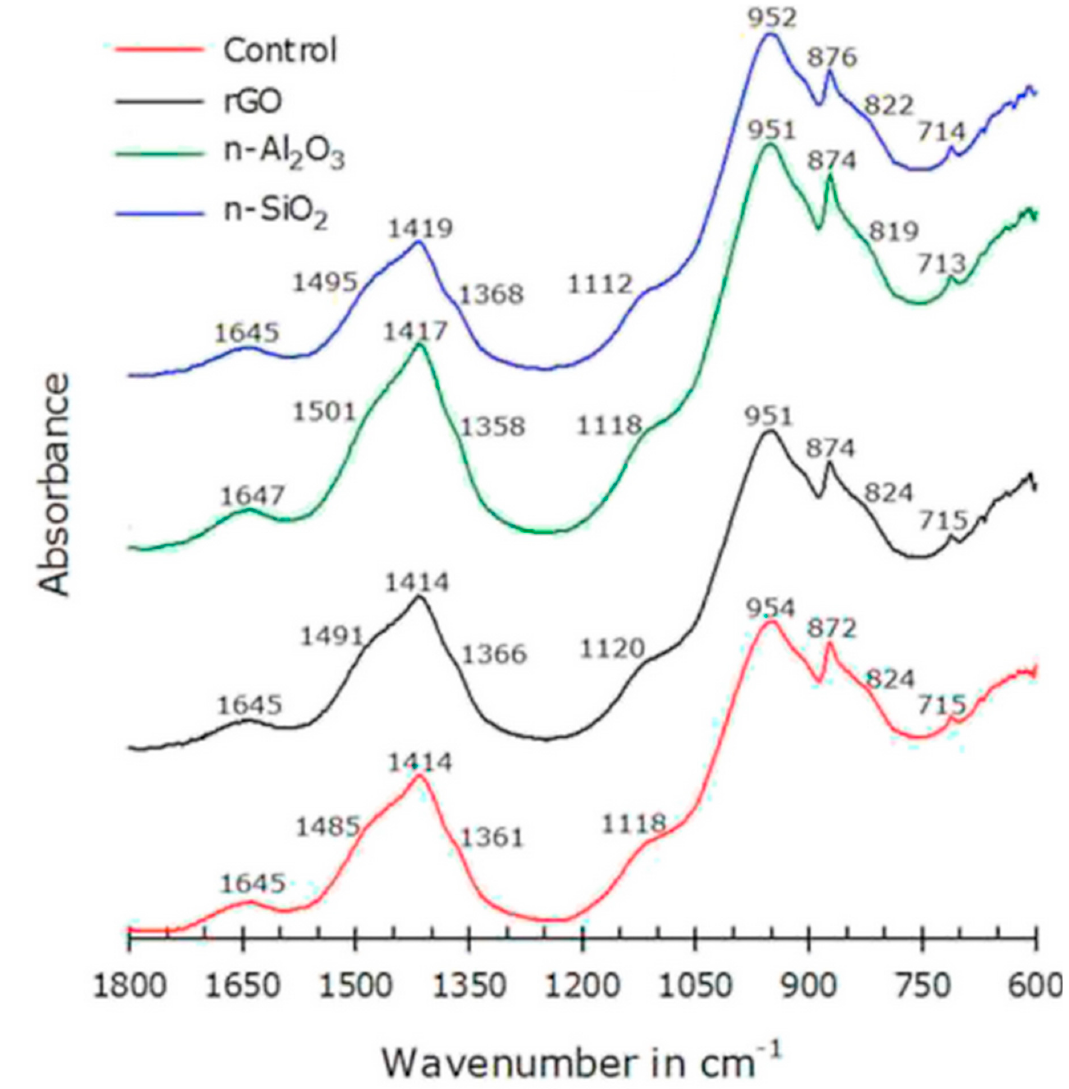
Figure 14. FTIR curve of the various pastes cured for 28 days. Reproduced with permission from [114], Elsevier, 2016.